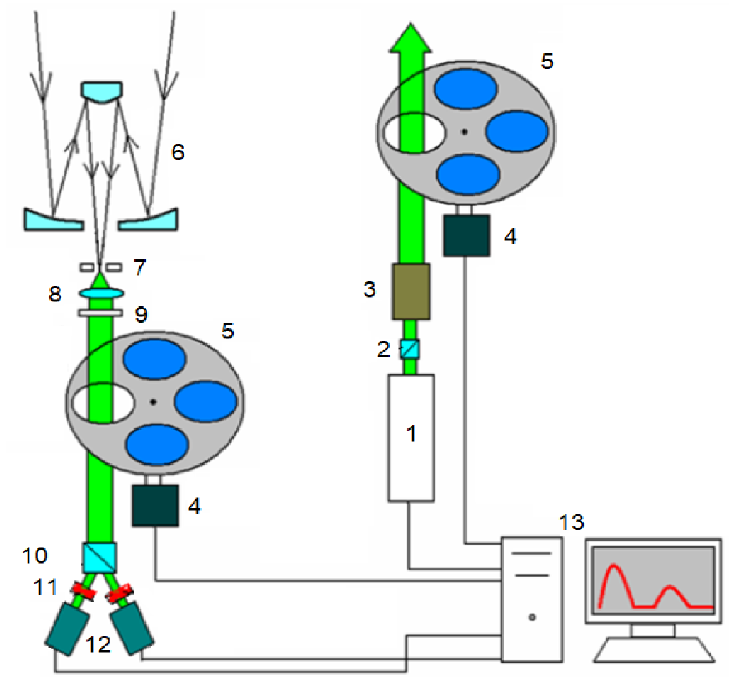
Figure 1. HAMPL block diagram: 1—laser; 2—Glan–Taylor prism; 3—collimator; 4—stepper motor; 5—polarization transformation unit; 6—Cassegrain telescope; 7—field stop; 8—lens; 9—interference filter; 10—Wollaston prism; 11—PMTs; 12—EOSs; 13—computer-based data recording and displaying equipment.